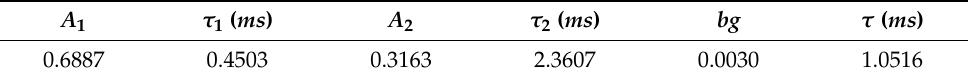
Table 3. Summary of the different parameters used to calculate PL lifetime of the representative SLF:20Yb,1Tm nanophosphor. A